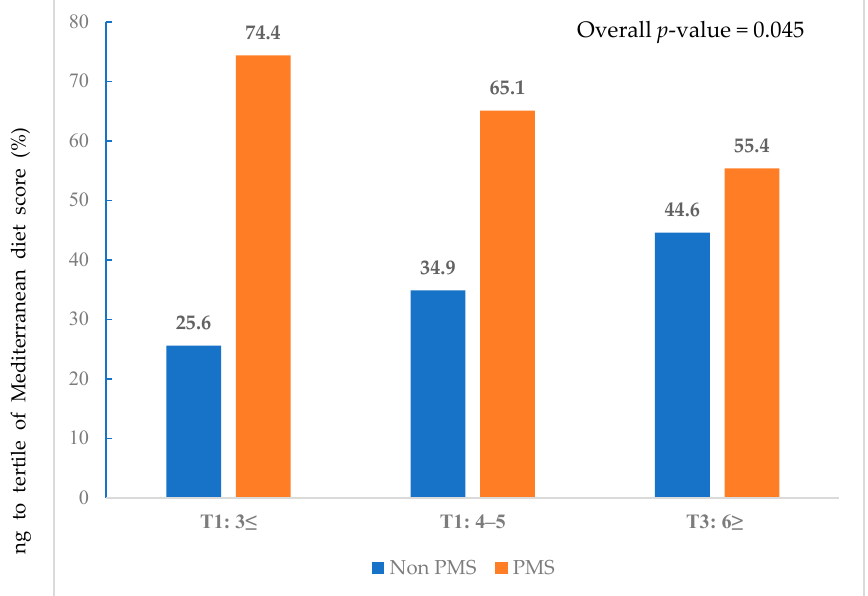
Figure 1. Proportions of participants without and with PMS according to Mediterranean diet score tertiles.